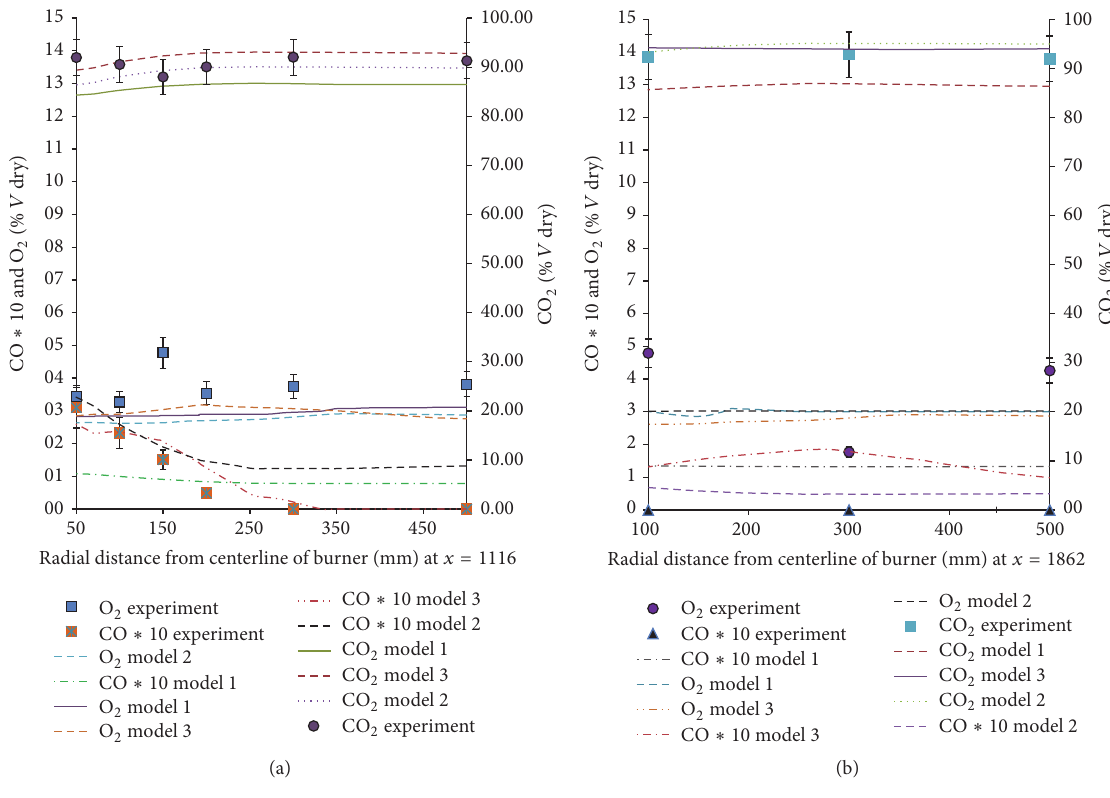
Figure 12: Predicted and measured volume percentages of CO ∗ 10 , CO 2 , and O 2 (dry basis) at (a) 𝑥 = 1116 mm and (b) 𝑥 = 1862 mm.